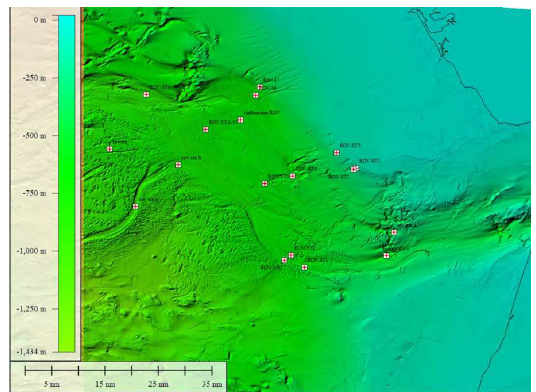
Figure 10. Argus ROV immersion